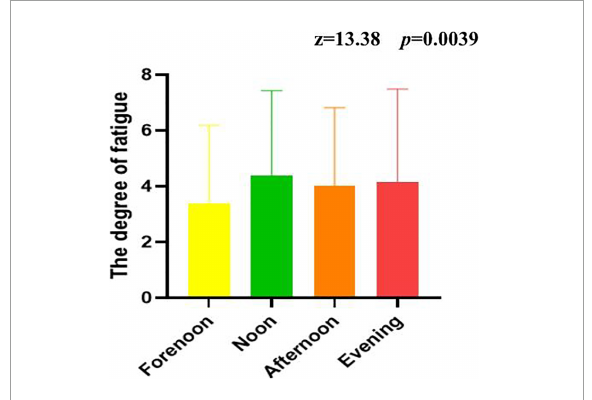
FIGURE1 The time pattern of fatigue of medical